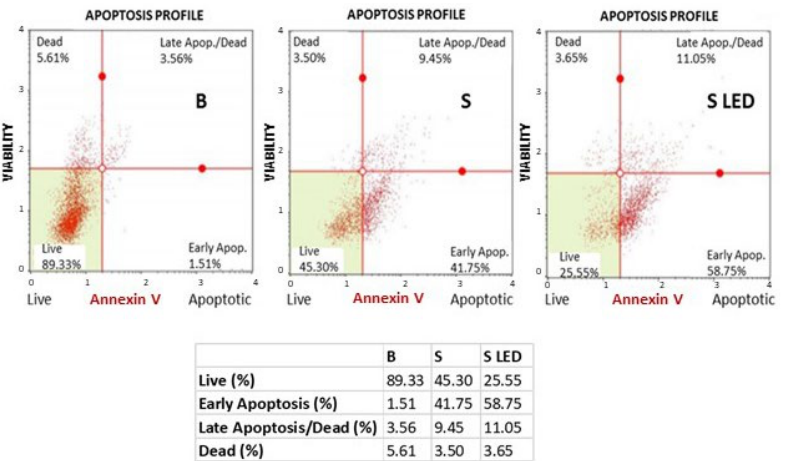
Figure 13. Annexin V cytofluorimetric evaluation in T98G cells. Cells (3000/96 wells) were incubated with 10 7 unloaded NPs (B) or NP BBR S (S) for an additional 24 h and subjected or not to 4 min light stimulation (447 nm and 1.2 mW/cm 2 of intensity). Trypsinized cells were then assayed with Muse Annexin V & Dead Cell Kit (Luminex). Following BBR localization within mitochondria and according to the induced apop- totic activation, a physiological evaluation of the organelles (i.e., the degree of membranes’ polarizatio ns) was assayed following NP BBR S and LED stimulation in T98G cells, through JC-1- specific cationic dye, which at low concentrations yields green fluorescence, while at higher concentrations, the dye forms aggregates that exhibit a broad excitation spectrum and an emission maximum at 590 nm. In detail, mitochondrial depolarization ∼ is indicated by a decrease in the red/green fluorescence intensity ratio. To this purpose, T98G cells, seeded at 70 – 80% confluence, were subjected to NP BBR S incubation (i.e., 3000 cells/96 wells incubated with 10 7 unloaded NPs (B) or NP BBR S (S) for an additional 24 h); before fluorescence microscope examinations, JC -1 (1 µM) was added for 15 min at 37 °C. As reported in Figure 14, discrete red spots represented physiologically polarized or- ganelles, while the green ones indicated depolarized mitochondria membranes, showing for this last event, in NP BBR S and NP BBR S LED treatments, a clear increase in their cellular distribution.